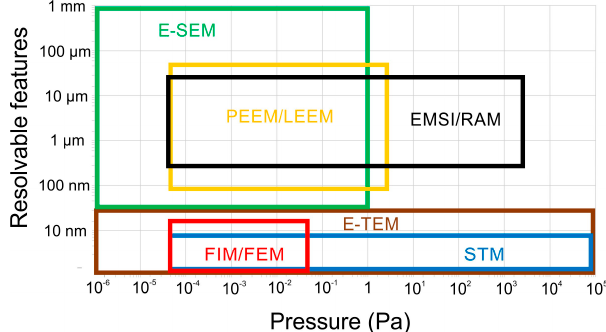
Figure 3. Application domains of different environmental microscopy techniques in terms of resolvable features and gas pressure permitted in the system under reaction conditions (see Table 1 for a detailed description of the techniques).